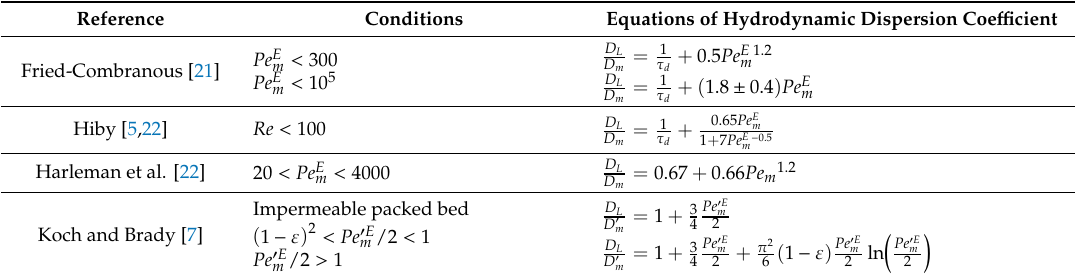
Figure 1. The packing types that were examined in this study: ( a ) face-centered cubic (FCC), ( b ) randomly packed spheres (RPS), and ( c ) body-centered cubic (BCC). Table 1. Summary of studies on hydrodynamic dispersion through packed beds in the randomly packed spheres (RPS)